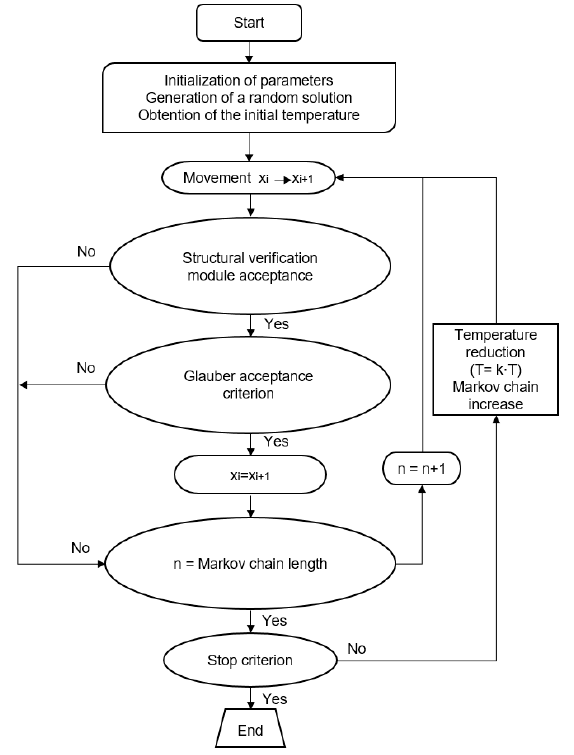
Figure 4. Optimization process flowchart.